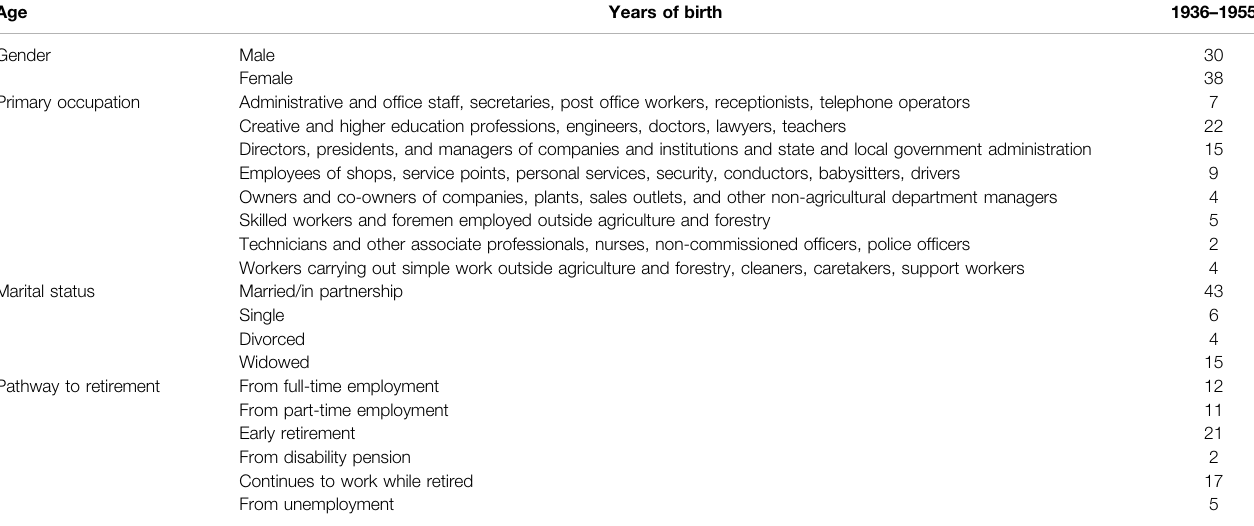
TABLE 2 | Sociodemographic characteristics of the